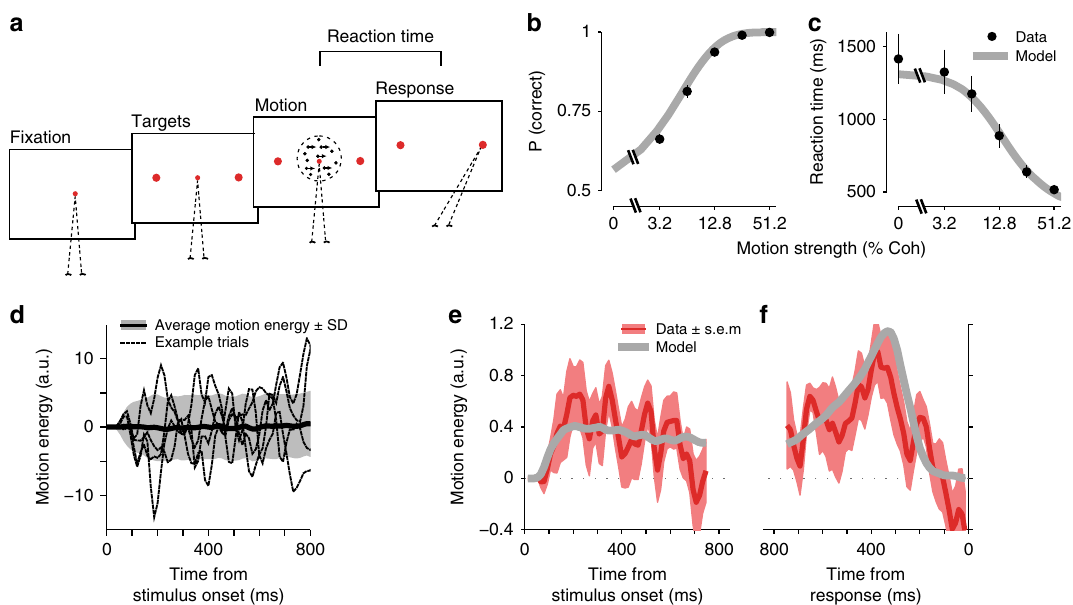
Fig. 4 Psychophysical kernels in the direction discrimination task match predictions of a bounded DDM with non-decision time. a RT task design. Subjects initiated each trial by fi xating on a central fi xation point. Two targets appeared after a short delay, followed by the random dot stimulus. When ready, subjects indicated their perceived motion direction with a saccadic eye movement to a choice target. The net motion strength (coherence) varied from trial to trial, but also fl uctuated within trials due to the stochastic nature of the stimulus. b , c Choice accuracy increased and RTs decreased with motion strength. Data points are averages across 13 subjects. Accuracy for 0% motion coherence is 0.5 by design and therefore not shown. Gray lines are fi ts of a bounded DDM with non-decision time. Error bars denote s.e.m. across subjects. d Motion energy of example 0% coherence trials (dotted lines), and the average (solid black line) and standard deviation (shading) of motion energy across all 0% coherence trials. Positive and negative motion energies indicate the two opposite motion directions in the task. e , f The bounded DDM predicts psychophysical kernels (gray lines), which accurately match the dynamics of subjects ’ kernels (red lines). Because the model sensory weights are stationary, kernel dynamics in the model are caused by the decision-making process and non-decision times. Kernels are calculated for 0% coherence trials. Shading indicates s.e.m. across subjects. All kernels are shown up to the minimum of the median RTs across (Fig. 5d – e). The psychophysical kernels of the three features (Fig. 5g) had rich dynamics. First, the eye kernels had larger amplitude than the mouth and nose kernels, suggesting that choices were more strongly in fl uenced by fl uctuations in the eye region 50,51 . Second, the stimulus-aligned kernels dropped gradu- ally over time, and the saccade-aligned kernels showed a characteristic peak a few hundreds of milliseconds prior to the choice. A multi-feature integration process with stationary weights for eyes, nose, and mouth regions could quantitatively explain our results. For each stimulus frame, the model calculated a weighted sum of the three features to estimate the momentary sensory evidence and then integrated this momentary evidence over time in a bounded diffusion model (Fig. 5f, see Methods). Fitting the model to the choice and RT distributions provided a quantitative match for both (Fig. 5d – e; R 2 , 0.998 ± 0.001 for accuracy and 0.98 ± 0.01 for RTs) and the resulting parameters led to kernels that well matched the dynamics of experimentally observed kernels for the three features ( R 2 , 0.74).